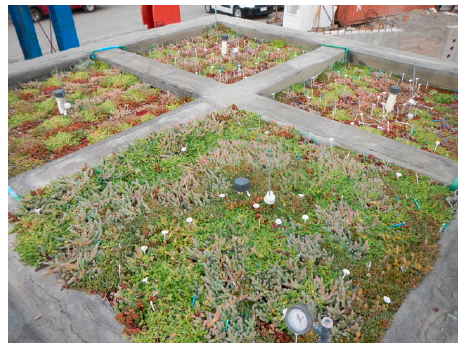
Figure 1. Photo of green roof specimens tested in the LIVE.